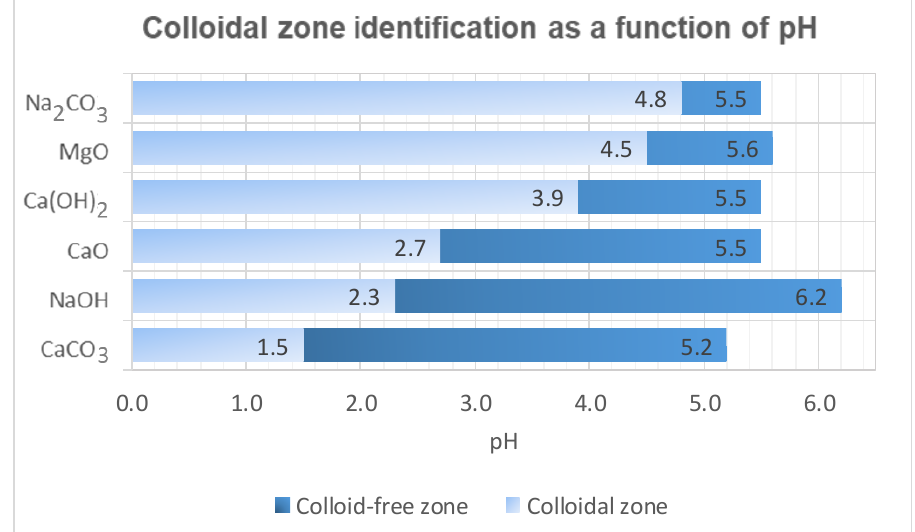
Figure 1. Identification of the colloidal zone for the test reagents.